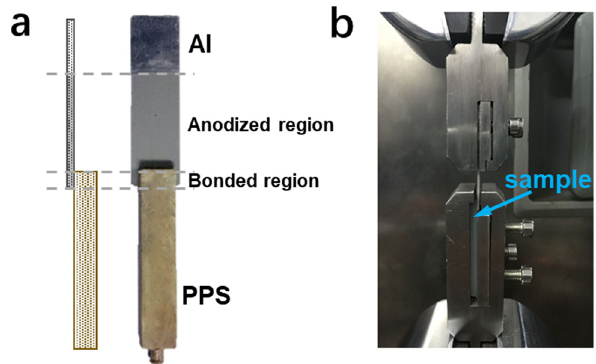
Figure 3: The digital photo of tensile testing: ( a ) the PMH sample and schematic illustration and ( b ) the test fi xture.